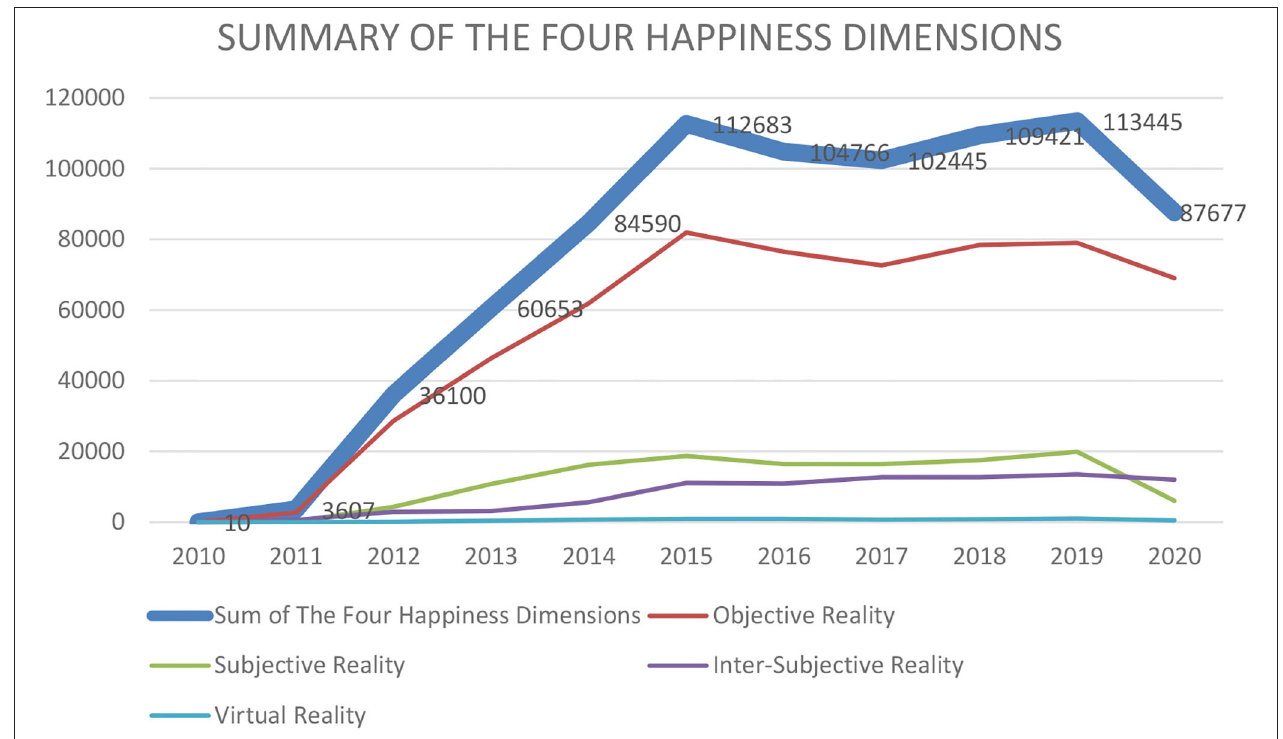
FIGURE 2 | Change of four happiness dimensions over